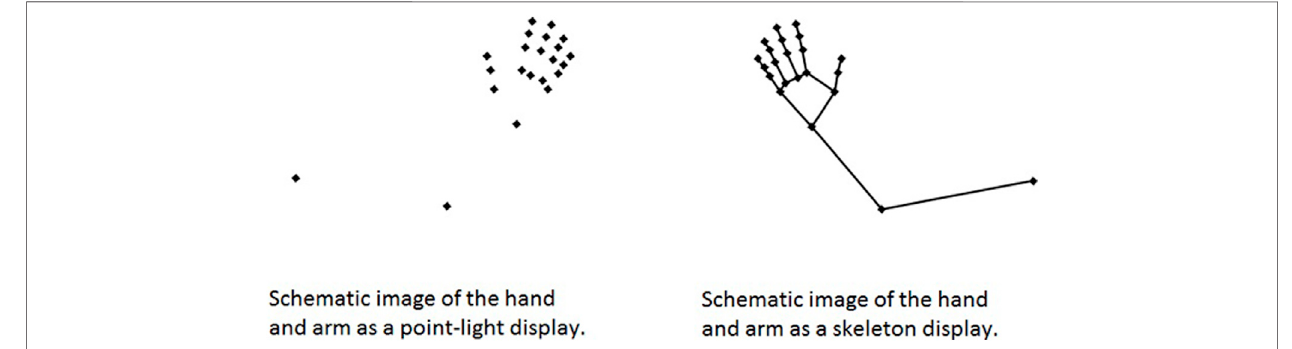
FIGURE 1 | Point-light and skeleton versions of the gesture stimuli.